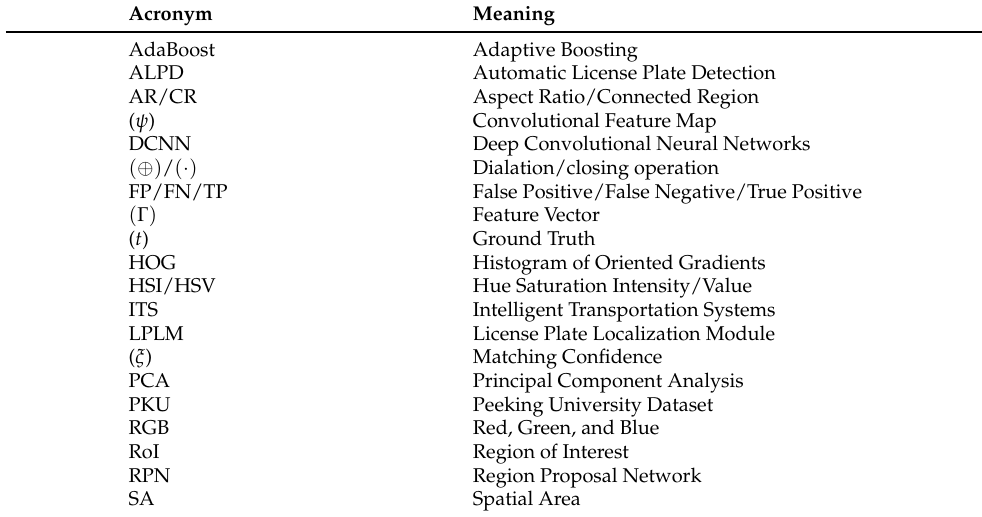
Table 1. Acronyms and their